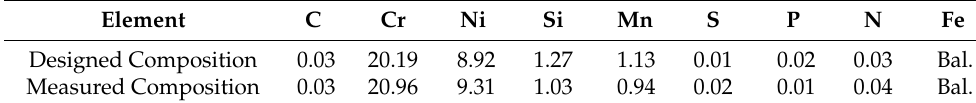
Table 1. Chemical composition of Z3CN20.09M cast stainless steel (wt.%). Element C Cr Ni Si Mn S P N Fe Designed Composition Measured